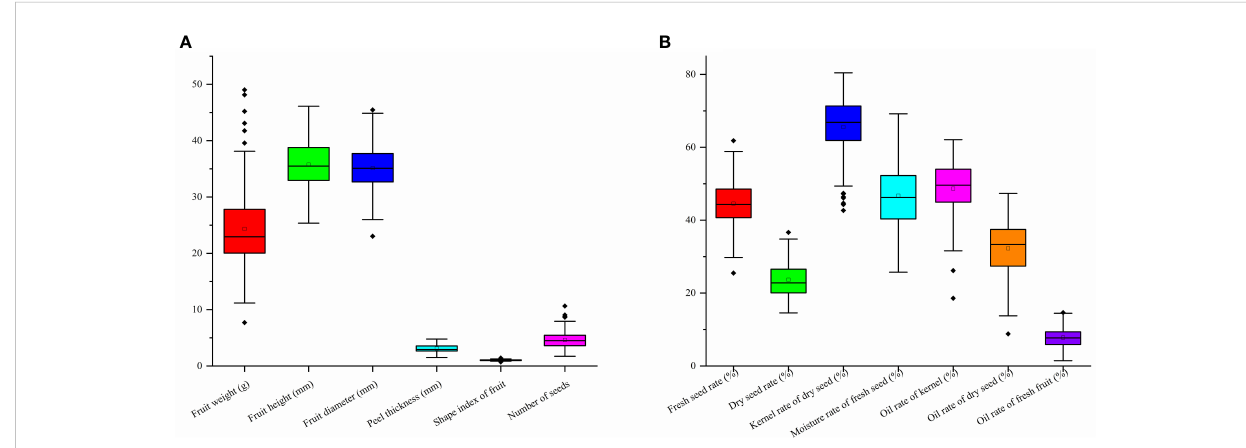
FIGURE 6 Fruit and oil content indexes variation of wild C . oleifera germplasm resources: (A) quantitative characters of fruit phenotypic characters and (B) quantitative characters of oil content